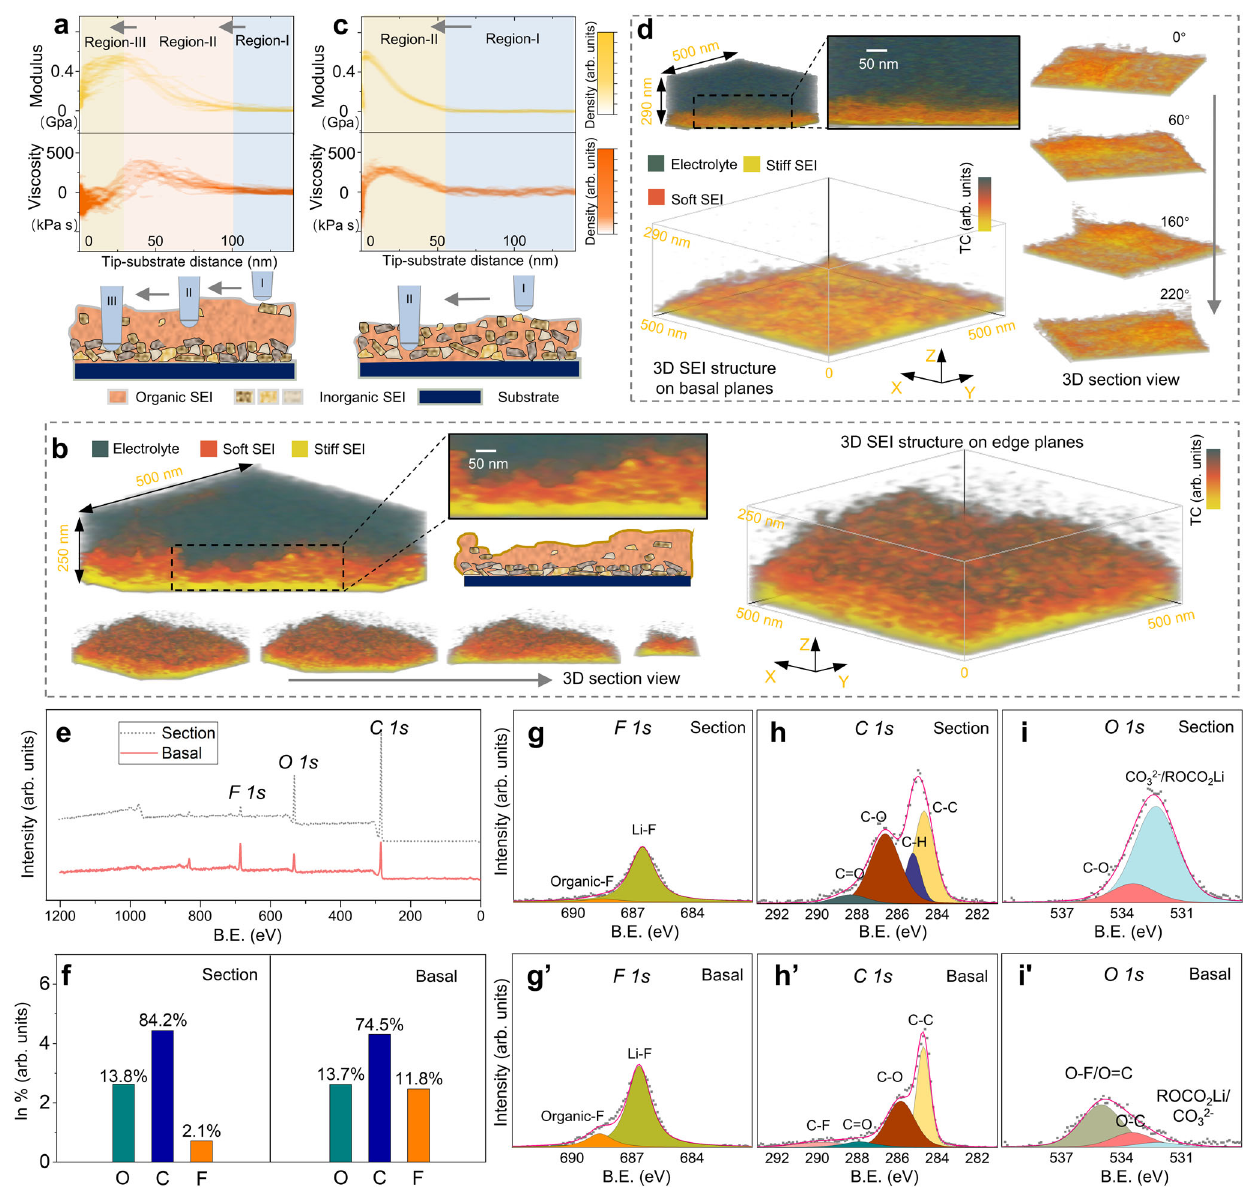
Fig. 2 | insitu3D nano-rheology microscopy (3D-NRM) and post-mortemX-ray photoelectronspectroscopy(XPS)characterizationofSEIstructureonsample section and basal planes. 3D-NRM maps the nanomechanical viscoelastic prop- erties of the SEI layer by penetrating it with the AFM tip. As the probing tip approaches the surface from the electrolyte, a sample is oscillated laterally at a small amplitude of few nm, and the in-phase and out-of-phase components of the lateral (shear) force acting on the tip are measured. By taking the derivative of the force over penetration increments, the effective shear modulus ( G ) and viscosity ( η ) distribution asa function of the depth of SEI layer isevaluated (Supplementary Fig. 8e). G and η distribution on the ( a ) edge plane section and c basal planes. The